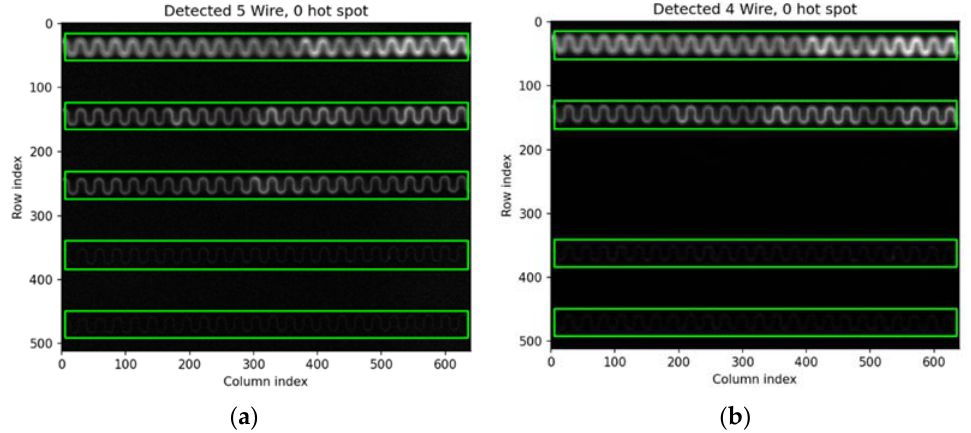
Figure 18. Demonstration of the wire breaks detection using the proposed method of Test Sample 1: ( a ) healthy condition of U-shaped wires; ( b ) one wire break in U-shaped wires.